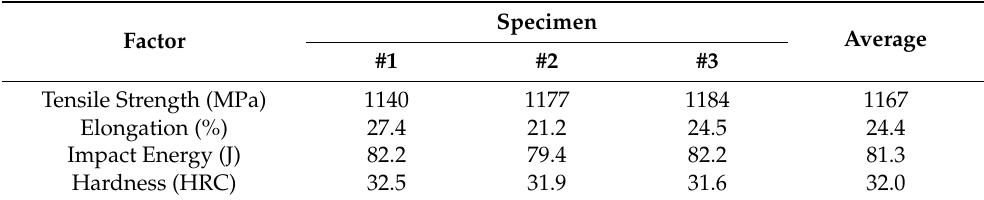
Figure 5. Main effects of S/N ratio for multiobjective optimization.